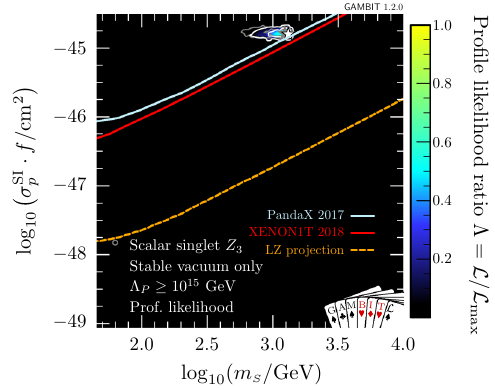
this conclusion is independent of the choice of prior on μ 3 .